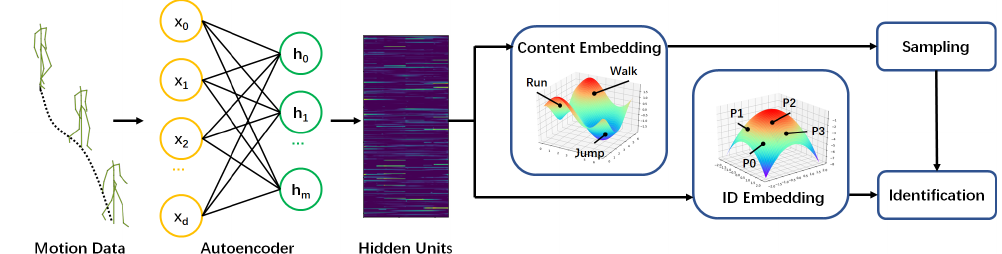
Figure 2. Flowchart of our gait synthesis